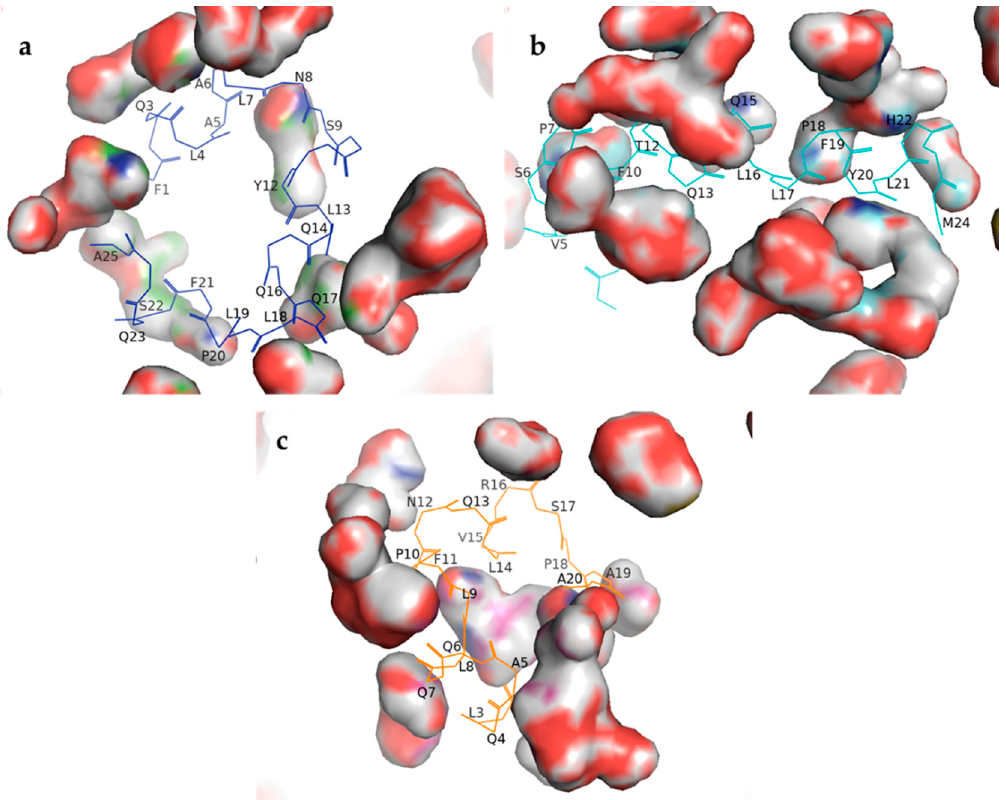
Figure 2. Peptide-solvent interactions based on the predicted structures of the synthesized peptides. The QUARK online Ab initio protein structure algorithm was used to obtain the models. Visual Molecular Dynamics version 1.93 was used to simulate peptide interactions with a physiological solvent (NaCl 0.15 mol/L, 37 °C and 10 ns) using equilibration and molecular dynamics simulations. PyMOL molecular graphics system version 2.3.4 was used to generate the 3D images. The surface of interaction is represented as solid bodies surrounding the peptide structure. Amino acids contributing to the peptide-solvent interaction are represented as one letter codes and their number in the sequence. ( a ) 19ZP1; ( b ) 19ZP2; ( c ) 19ZP3.